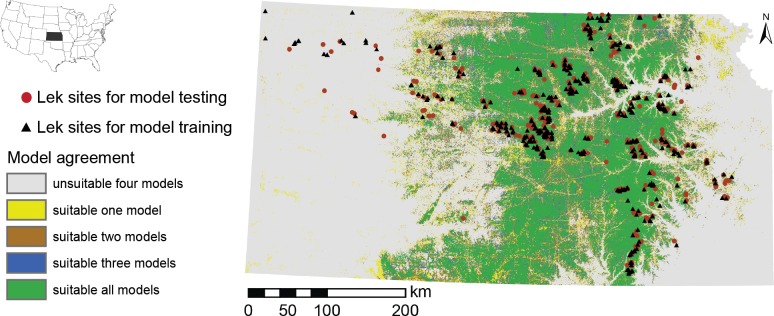
Model consensus map of suitability for Greater Prairie-Chicken in Kansas.Map constructed by summing the four individual models (see Fig 1). The highest model consensus for presence (four models) is shown in green and the lowest (one model) in yellow. Areas predicted absent by all four models are shown in gray. The 870 unique lek sites in Kansas from 2003–2011 are separated in training dataset (black triangles) and testing dataset (red dots).